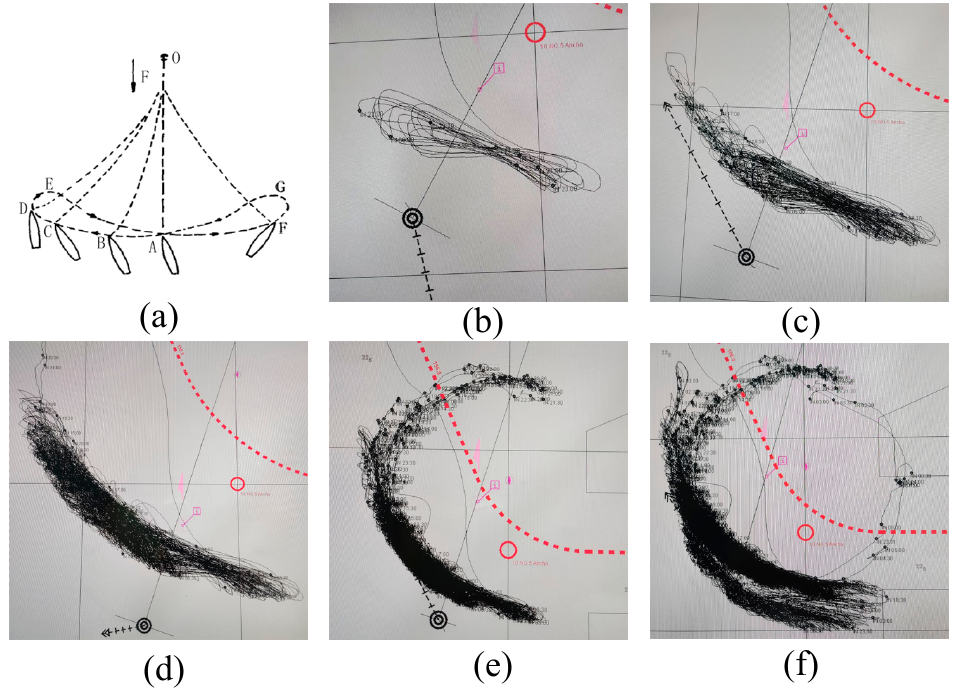
Figure 2. Diagram of plane motion of the anchoring ship. ( a ) Motion diagram of single anchored ship. ( b ) Ship motion trajectory of single anchored ship within 12 h. ( c ) Ship motion trajectory of single anchored ship within 24 h. ( d ) Ship motion trajectory of single anchored ship within 5 days. ( e ) Ship motion trajectory of single anchored ship within 10 days. ( f ) Ship motion trajectory of single anchored ship within 15 days.